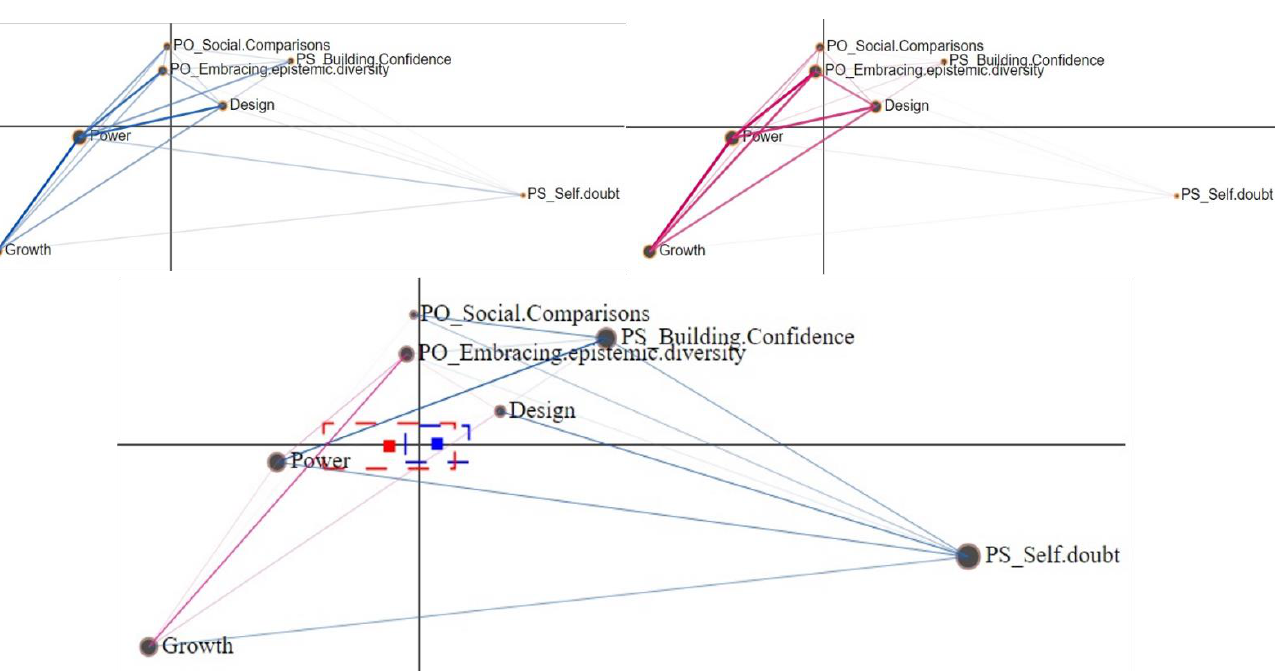
Epistemic Network Analysis of Codes in Collective Reflection